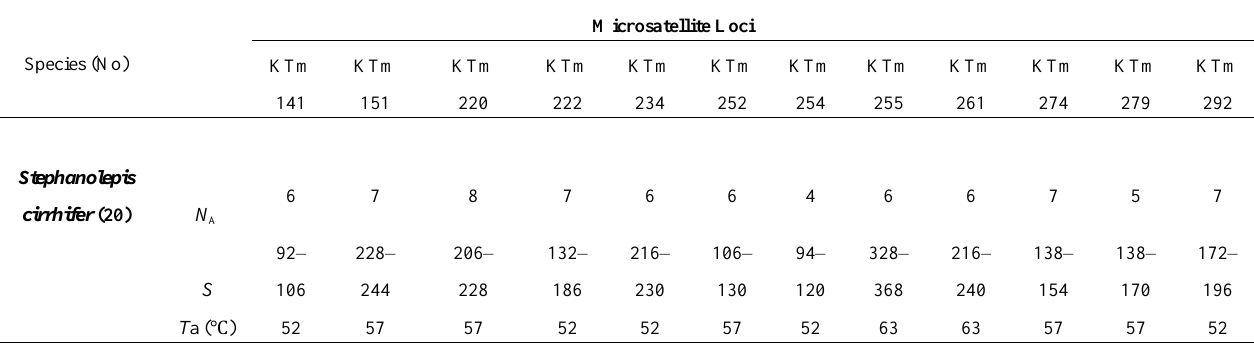
Table 3. Cross-species amplification of Stephanolepis cirrhifer using Thamnaconus modestus microsatellite